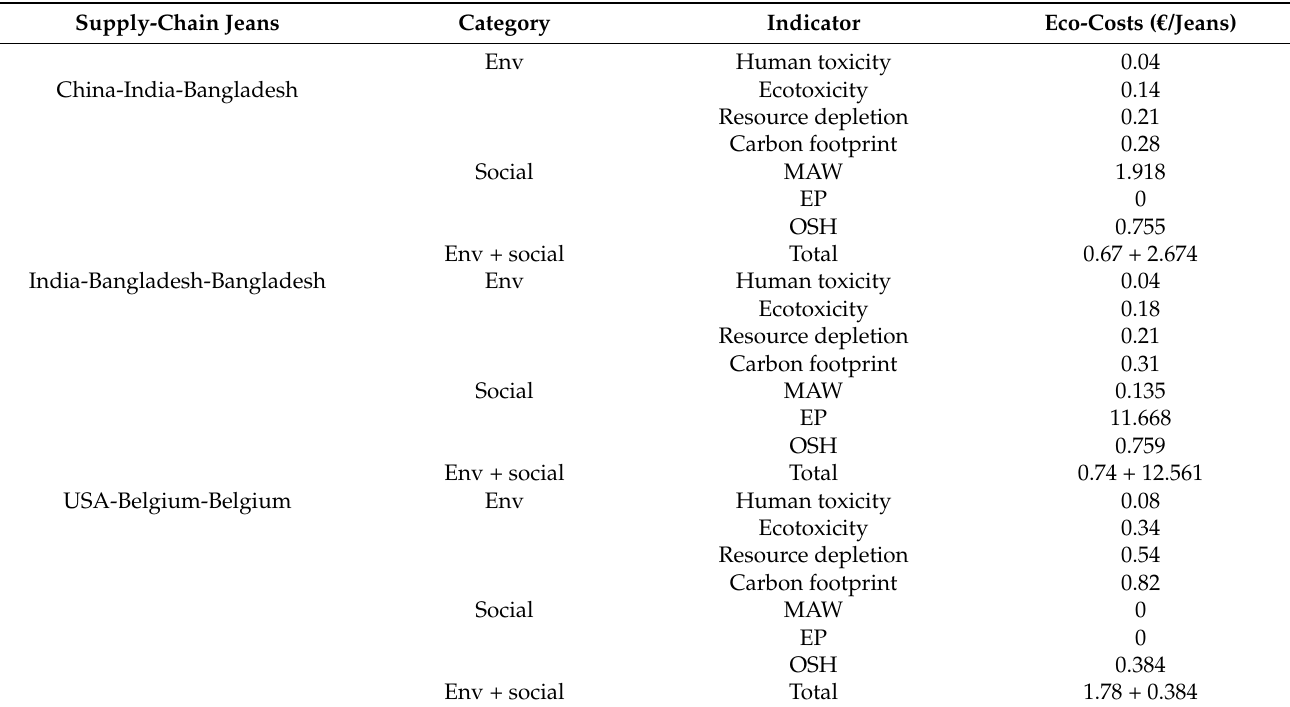
Table 2. Example of eco-cost analysis (e-LCA combined w/ s-LCA) of a pair of jeans [25,40], in the context of research not applied in the industry. MAW—minimal acceptable wage, EP—extreme poverty, OSH—occupational safety and health. Supply-Chain